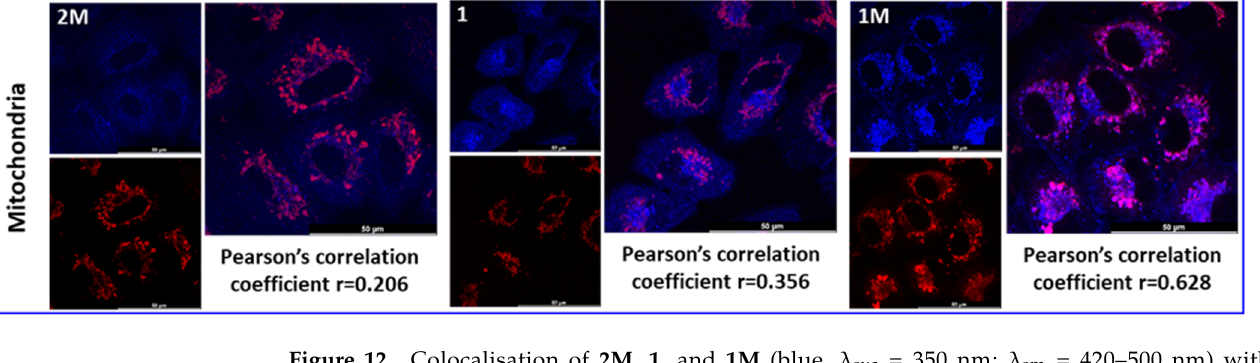
Figure 12. Colocalisation of 2M , 1 , and 1M (blue, λ exc = 350 nm; λ em = 420–500 nm) with MitoTracker ® (Deep Red) observed by confocal microscopy. Cells were treated with 10 µM of the compound for 90 min at 37 °C and incubated with 100 nM MitoTracker ® for 20 min at 37 °C. Collocalisation is assessed by Pearson’s coefficient. Analysis was conducted using ImageJ software and the appropriate JACoP plugin [53].